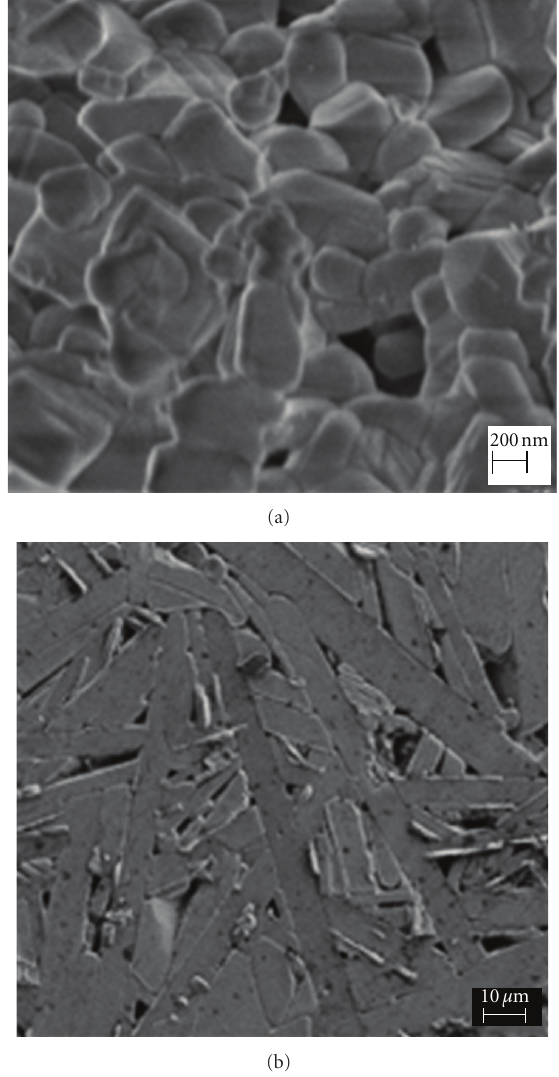
Figure 2: FESEM image of BiT: (a) calcined powder at 750 ◦ C for 3 hours and (b) sintered bulk ceramic at 1100 ◦ C for 3